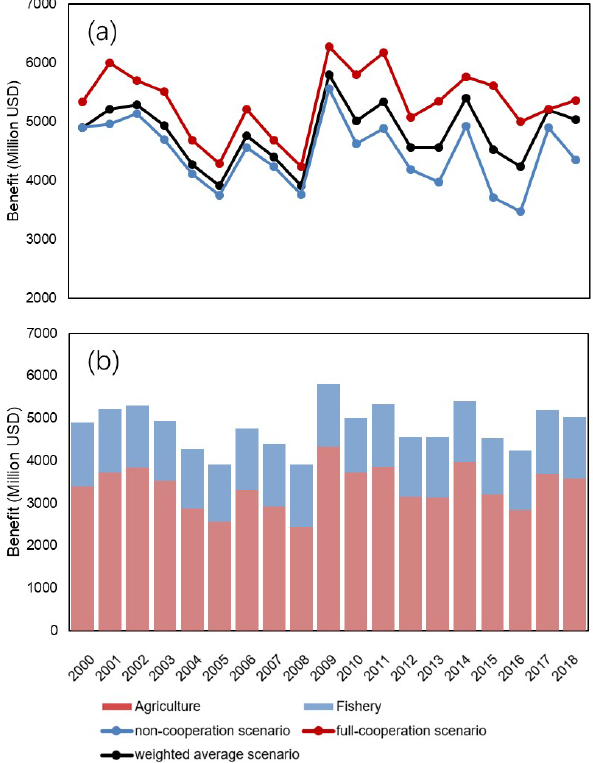
Figure 9. Benefit of upstream China (a) and Laos (b) under the weighted average scenario, non-cooperation scenario and full- cooperation scenario. Figure 10. (a) Benefits of Thailand, Cambodia and Vietnam under the weighted average scenario, non-cooperation scenario and full- cooperation scenario. (b) Agriculture and fishery benefits of down- stream under the weighted average